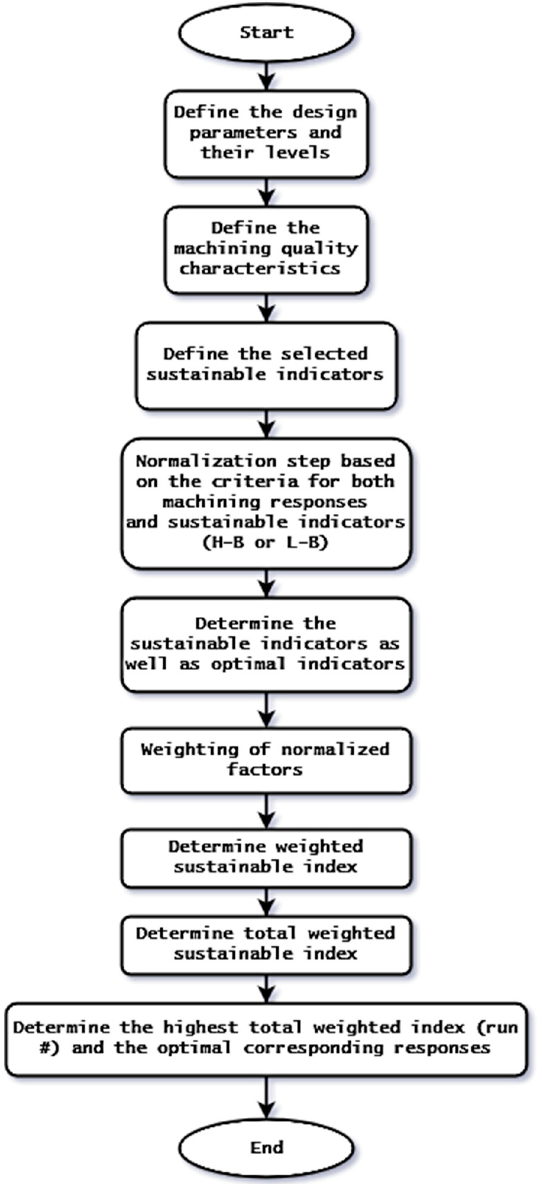
Figure 5. A flow chart for the sustainability assessment model [36].